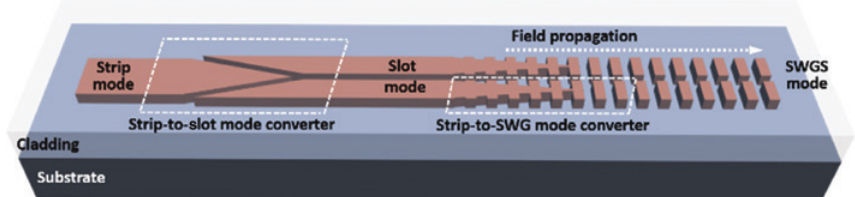
Figure 2: 3D structure of the strip-to-SWGS mode converter, consisting of one strip-to-slot mode converter and two strip-to-SWG mode converters.